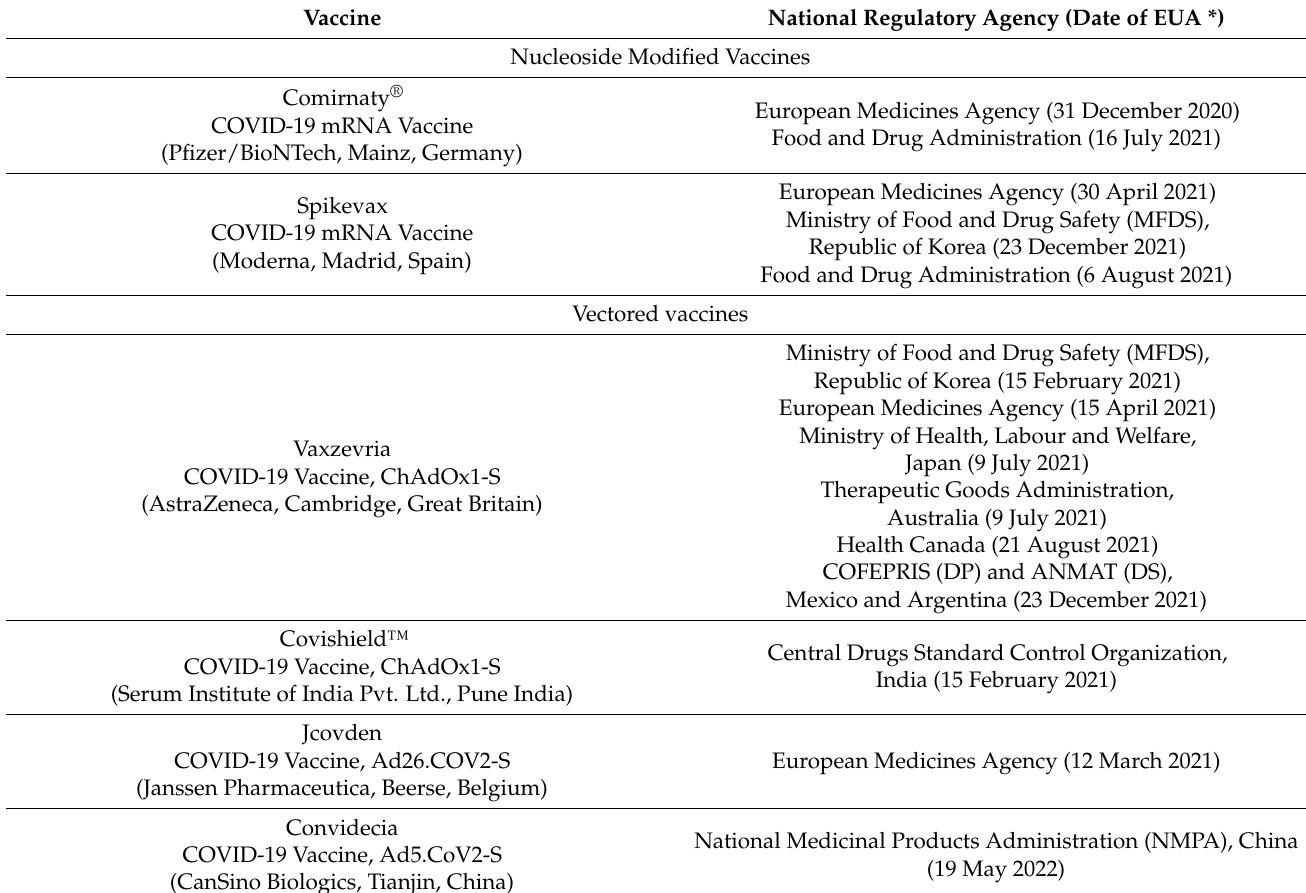
Table 1. Vaccines against SARS-CoV-2 emergency use listed by the World Health Organization (WHO).